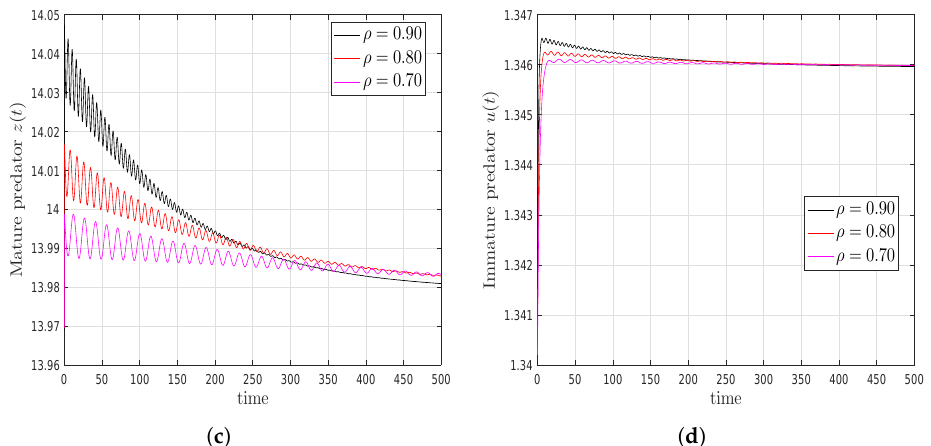
Figure 12. Time series graphical representations for food web mathematical System (13) with general- ized Caputo fractional operator when ϕ =